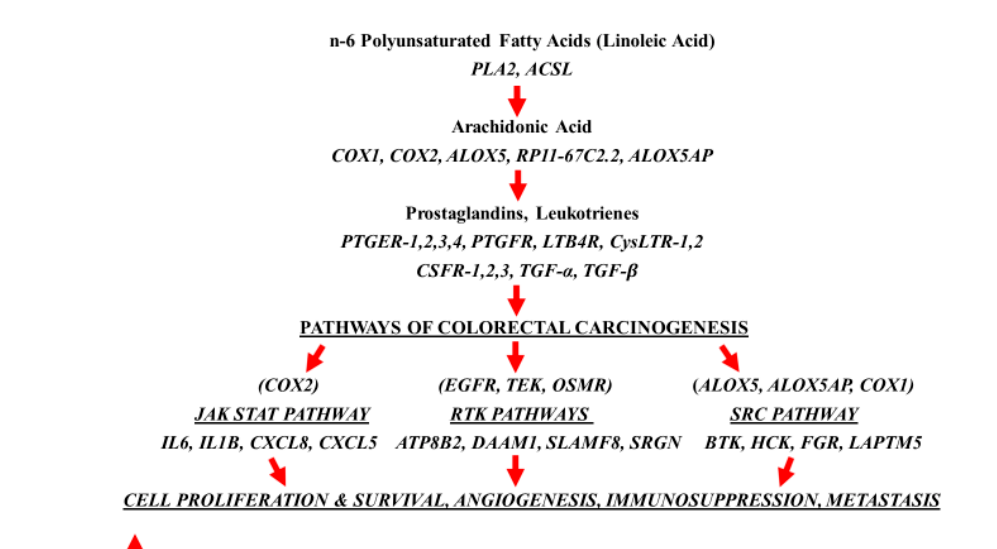
Figure 4. Inflammogenesis model of colorectal carcinogenesis. Genes and pathways in the model. Arachidonic Acid biosynthesis: Phospholipase A2: PLA2, Acyl-CoA synthetase: ACSLl;